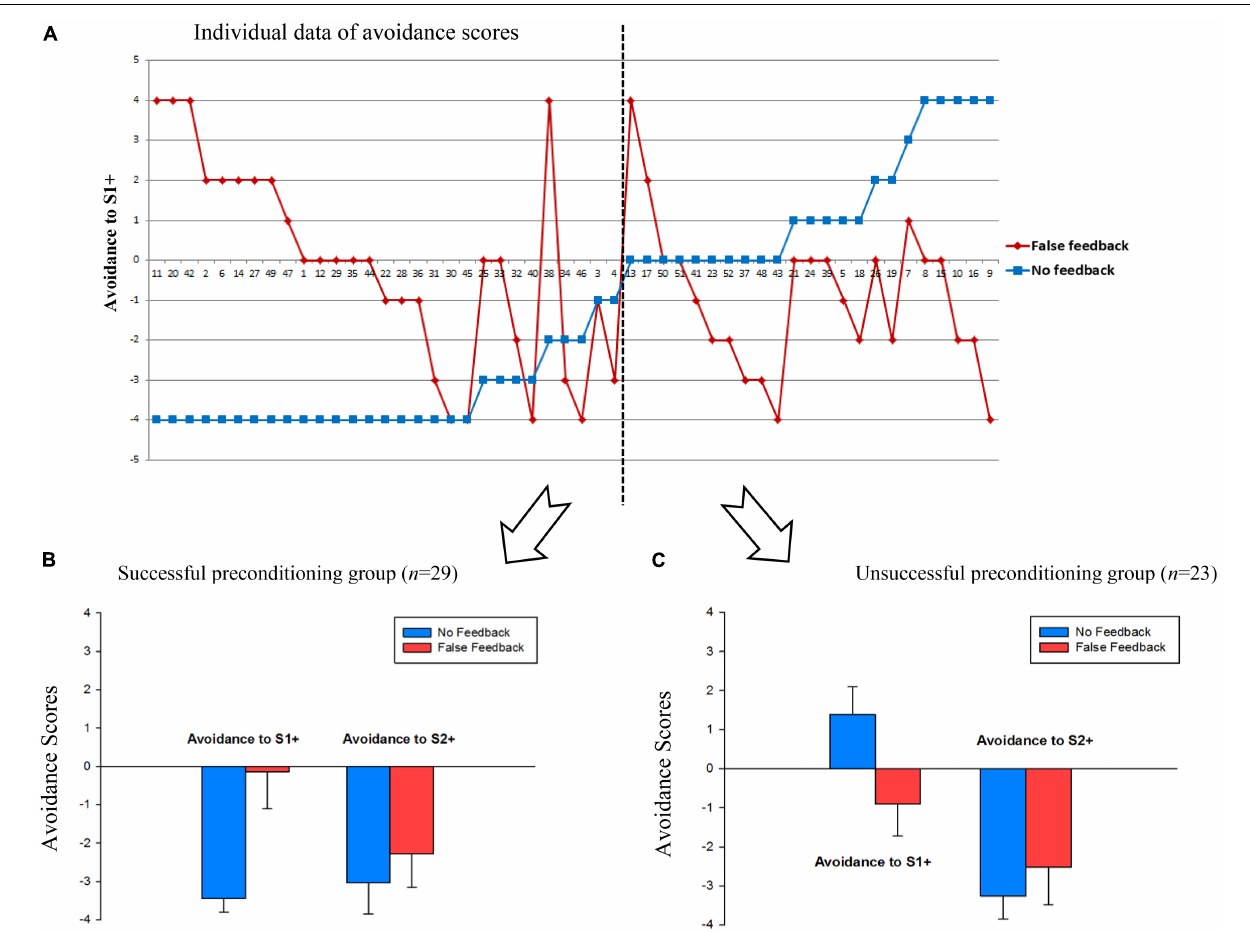
FIGURE 3 | (A) Individual data of avoidance scores in false and no feedback conditions. Avoidance score = (Times of choosing S1 +)—(Times of choosing S1-). The smaller the value, the more avoidance to S1 +. Each number on the X-axis represents one participant. Error bars represent 95%CI. (B) Avoidance scores to S1 + and S2 + stimuli in the successful preconditioning group. (C) Avoidance scores to S1 + and S2 + stimuli in the unsuccessful preconditioning